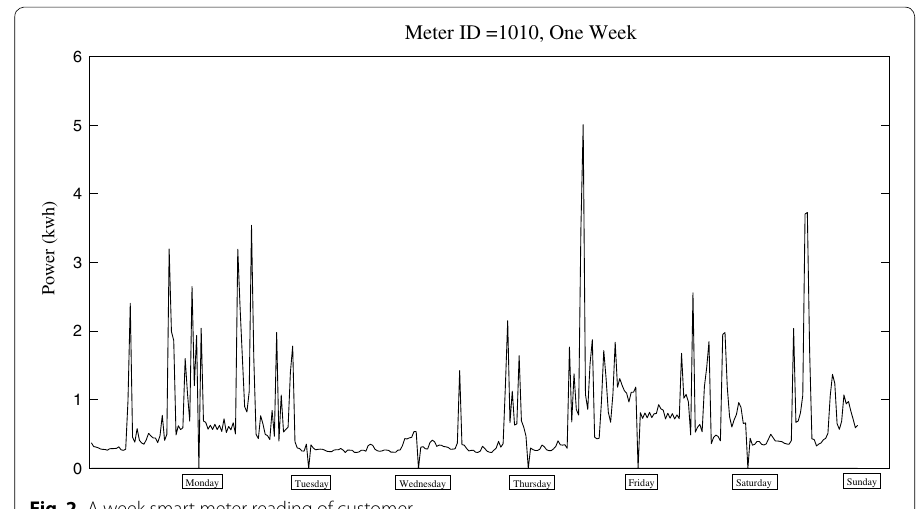
Fig. 2 A week smart meter reading of